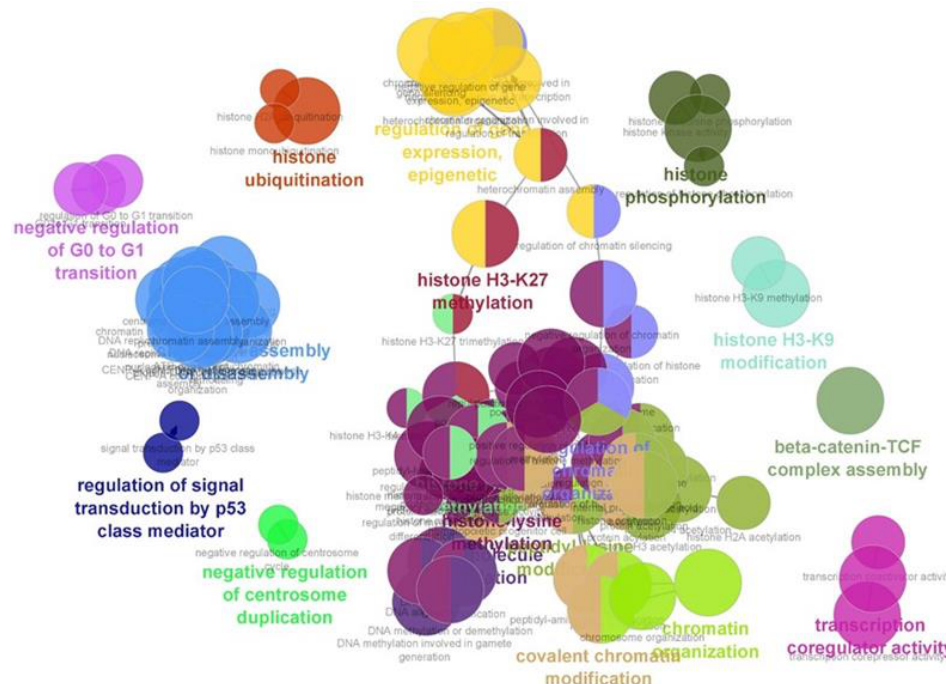
Figure 5. Andrographolide inhibits EBV lytic reactivation by induction of histone modifications. The differentially expressed proteins that were associated with histone modifications were analyzed for their molecular function by ClueGO. These proteins were functionally associated with histone H3-K27 methylation, histone H3-K9 modification, histone ubiquitination, β -catenin-TCF complex assembly, regulation of signal transduction by p53 class mediator, negative regulation of G0 to G1 transition, covalent chromatin modification and others.